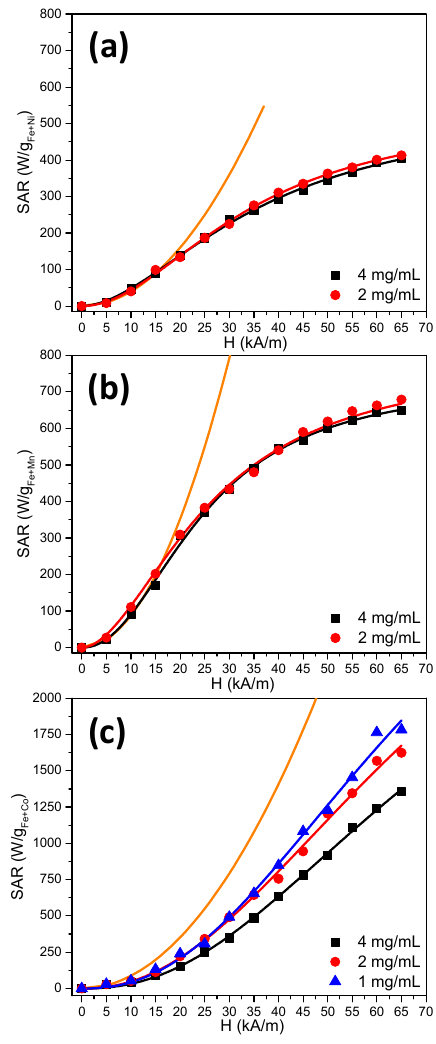
Figure 4. SAR dependence on the amplitude of the magnetic field strength for ( a ) NiFe 2 O 4 , ( b ) MnFe 2 O 4, and ( c ) CoFe 2 O 4 dispersed in water at the indicated concentration together with the fits with the logistic function. The orange line in each panel represents the parabolic evolution of SAR with the amplitude of the magnetic field strength according to the Linear Response Theory [13].